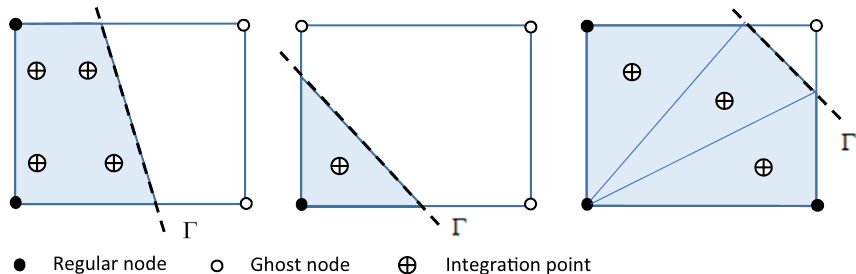
Fig. 3 A Q4 element crossed by a boundary showing the subdivision